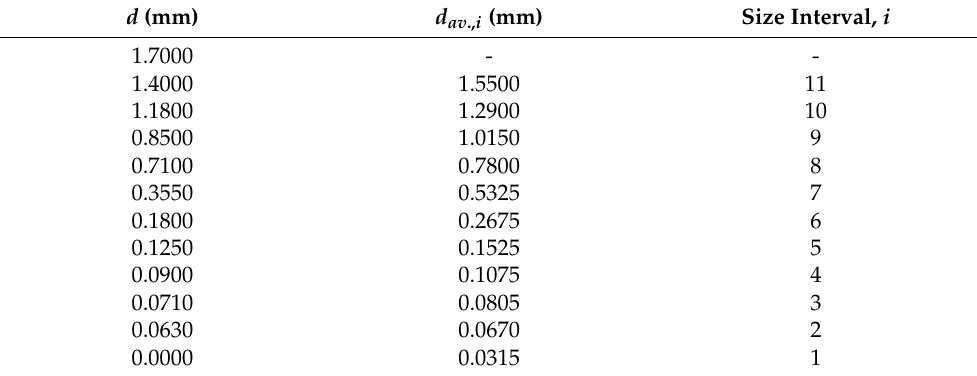
Figure 3. Photographs of jar with ‘Granny Smith’ apples sealed with an LDPE film for respiration measurement.